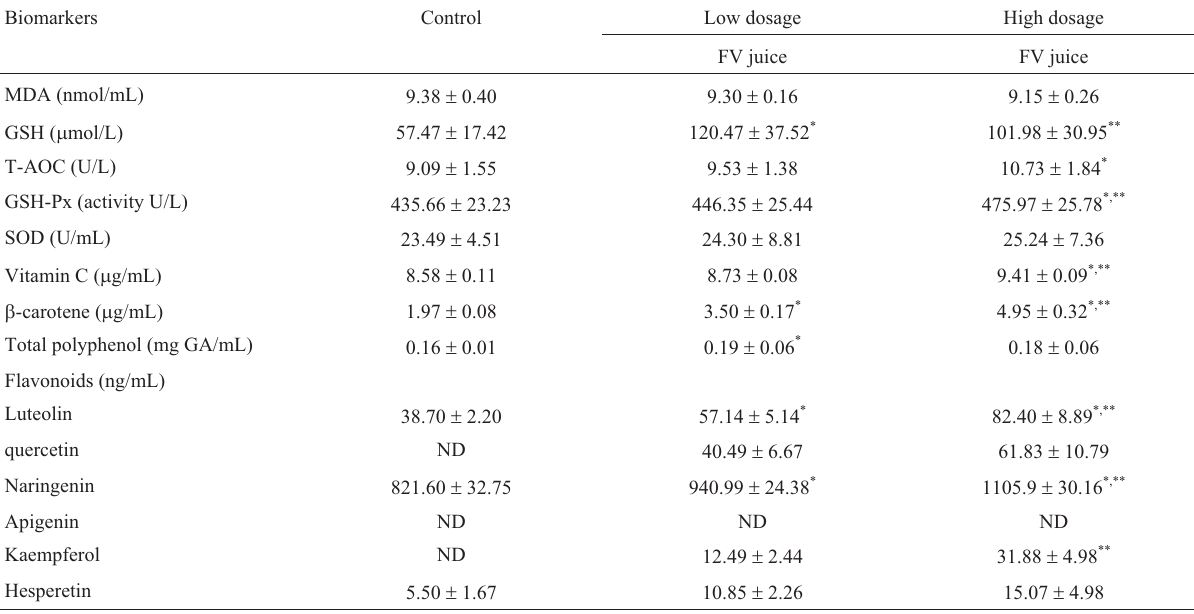
Table 1 - Effects of fruit and vegetable (FV) juice dietary intervention on serum antioxidant parameters.